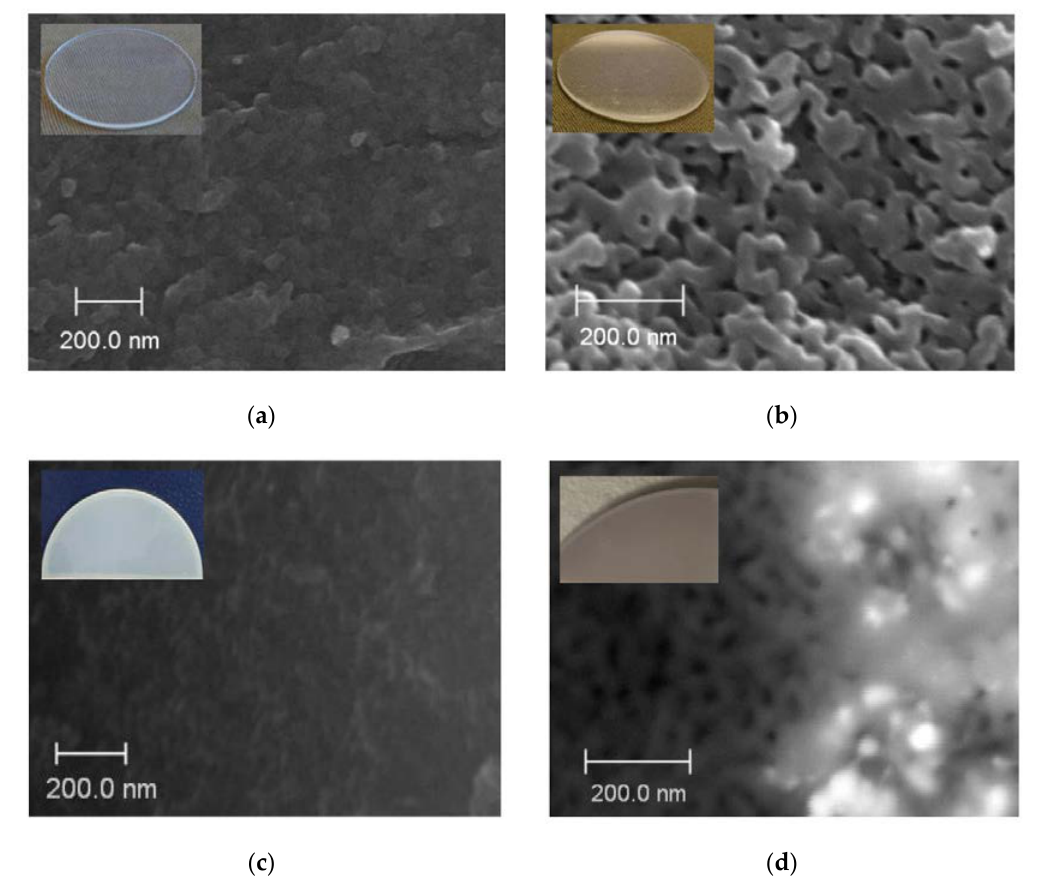
Figure 3. SEM images of the cross-section of the base MIP ( a ) and MAP ( b ) membranes and doped by Ag/AgCl, respectively ( c , d ).